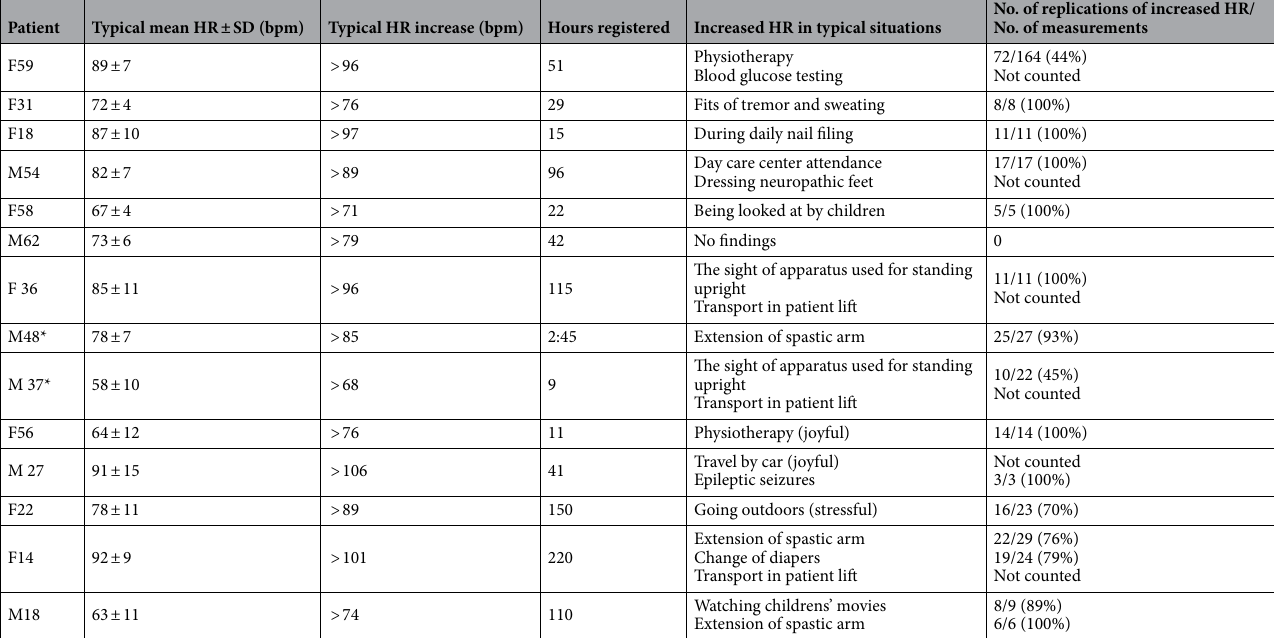
Table 2. Heart rate (HR) observations. Typical mean HR in beats per minute (bpm) and 1 standard deviation (SD) for each participant. The mean HR, SD and HR increase (> mean HR+ 1SD) were calculated daily. Typical situations that were associated with increased HR are given together with number of replications/total number of observed situations. Eight participants were interpreted as experiencing pain or distress during episodes with increased HR; three participants (F56, M27, and M18) were considered to experience joy during some of the episodes with increased